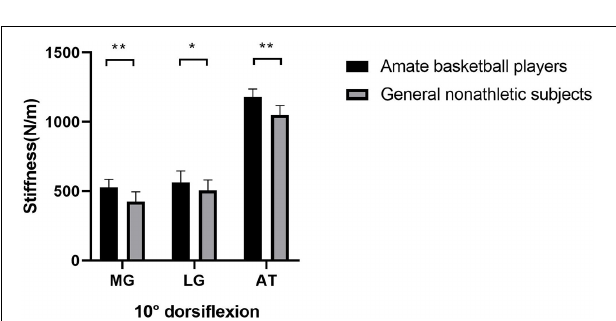
FIGURE 2 | The mean stiffness of the LG, MG, and AT between amateur basketball players and the general non-athletic subjects at dorsiflexion 10 ◦ of ankle joint. Amateur basketball players (black) and general non-athletic subjects (gray). ** P < 0.001, * P < 0.05.